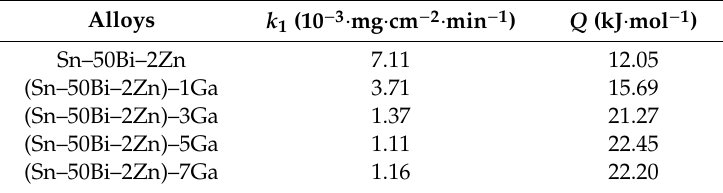
Table 2. The first stage oxidation rate constant and activation